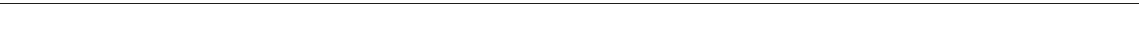
Fig. 2 Loss of proteasome activity increases HTT levels in iPSCs. a Western blot of iPSCs with antibodies to total HTT, polyQ-expanded proteins and β - actin. Arrow indicates mutant HTT detected with total HTT antibody in HD Q180-iPSCs. The images are representative of three independent experiments. b Western blot of control iPSCs #2 treated with MG-132 (12 h). The graph represents the relative percentage values to DMSO-treated iPSCs of normal huntingtin (nHTT) detected with total HTT antibody and corrected for β -actin loading control (mean ± s.e.m., three independent experiments). c Western blot of HD Q71-iPSC line #1 treated with MG-132 (12 h). Graphs represent the relative percentage values to DMSO-treated iPSCs (corrected for β